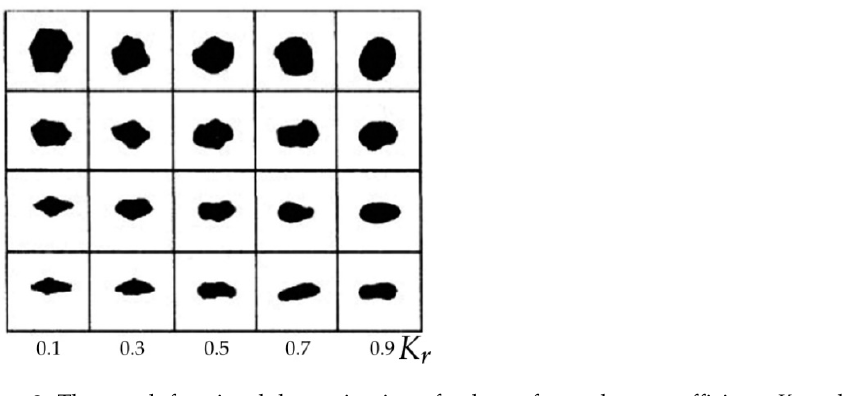
Figure 3. The graph for visual determination of values of roundness coefficients K r and spherical shape factors K s of solid particles of mechanical impurities.